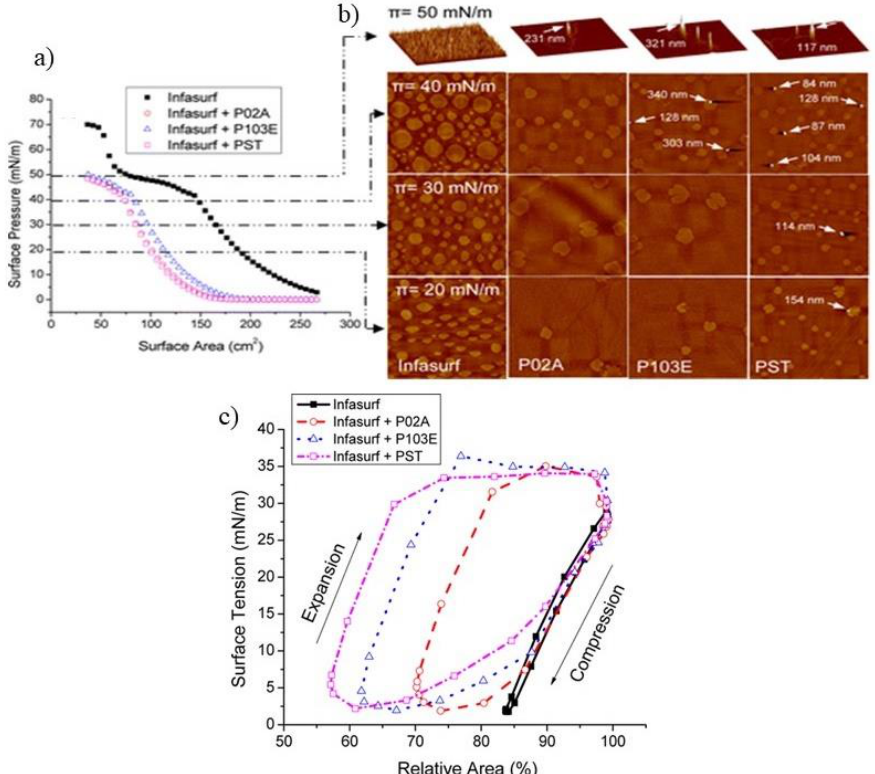
Figure 10. ( a ) Modification of the compression isotherms of an LS model for the compression isotherm of an LS model. ( b ) AFM micrograph showing the lateral structure of Langmuir – Blodgett films at three different surface pressures of the LS model and LS models upon the incorporation of three different types of hydrophobic polymer particles. All 2D images are shown at a resolution of 50 μm × 50 μm and have a z -range of 5 nm. The high-pressure images are shown in 3D to capture the topographic contrast between the particles and multilayer structures. The presence of NPs, denoted by white arrows, increases with increasing hydrophobicity. ( c ) Compression – expansion cycles for the pure LS model and LS model upon the incorporation of three different types of hydrophobic polymer particles. Dynamic cycling was conducted under physiological temperature (37 °C) and cycling speed (3 s/cycle). Reprinted from Valle et al. [227] , with permission from American Chemical Society, Copyright 2014.